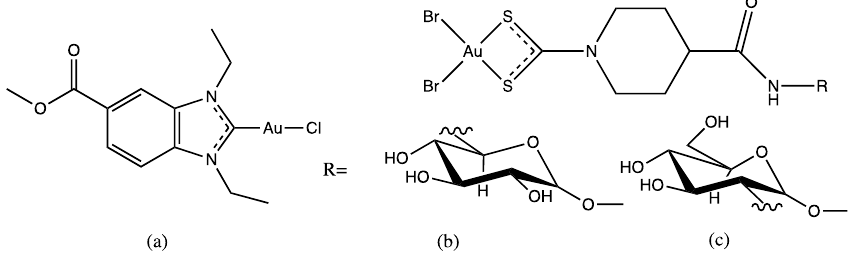
Figure 4. Gold complexes tested against SARS-CoV-2: ( a ) Gold(I) NHC complex; ( b ) and ( c ) are Gold(III)-dithiocarbamato complexes